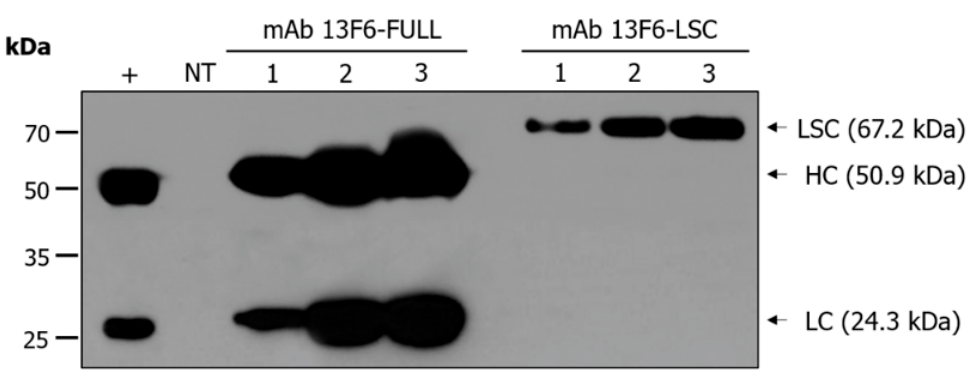
Figure 3. Immunoblot analysis of mAb 13F6-FULL and mAb 13F6-LSC in transgenic N. tabacum plants. An immunoblot analysis was performed to identify the LC and HC of mAb 13F6-FULL and LSC of mAb 13F6-LSC proteins in transgenic plants. Samples of each transgenic N. tabacum plant were homogenized with 1 × phosphate-bu ff er saline (PBS) to confirm the protein expression level. The mAb 13F6-FULL and mAb 13F6-LSC were detected by the goat anti-human Fc fragment specific antibody and the goat anti-human immunoglobulin G (IgG) Fab fragment specific antibody, respectively. Numbers on the left indicate molecular weight (kDa). + : commercial 13F6 antibody (mAb 13F6-C) as the positive control; NT: non-transgenic N. tabacum plant as the negative control; 1–3: transgenic line #.